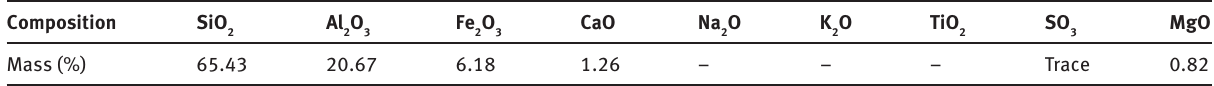
Table 2 Chemical composition of fly ash. Composition